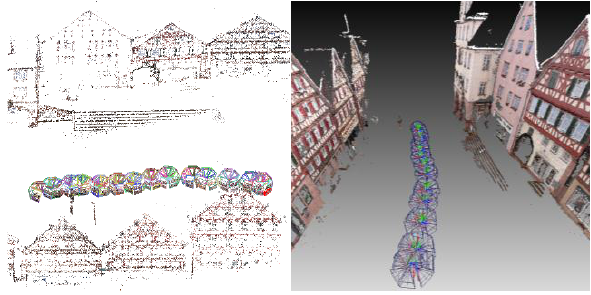
Figure 13: Acquisition of facades in Calw, Germany using the strategy “One panorama each step”. Left: VisualSfM, Right: dense